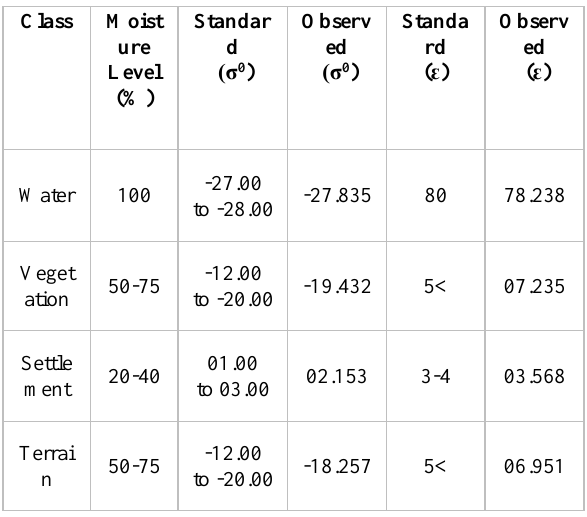
Figure 4. Occurrence plane for microwave RADARSAT-2 SAR H A Alpha classified image. From the occurrence plane, it is observed that anisotropic particle present in H A alpha classified image is high. This indicates that the more moisture level and high ε value of the object present in the image. However, the dataset is microwave C band having a lower frequency 4 to 8 GHz with the wavelength of 3.75 cm to 7.5 cm therefore the less σ 0 is occurred, and surface appeared as dark, which indicates the surface is smoother. The table 2 indicates that the σ 0 and ԑ for approximate soil moisture level measured with the help of statistical parameters and occurrence plane obtained from the software tool. Table 2. σ 0 and ԑ for H A Alpha classified Vancouver, Canada RADARSAT-2 SAR